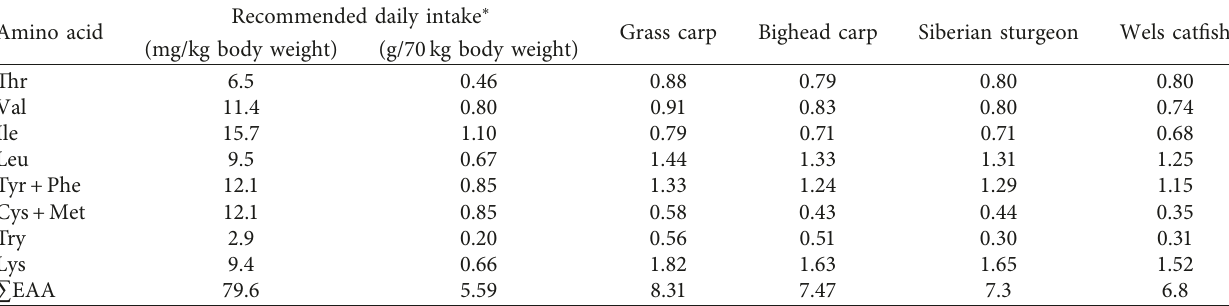
Table 6: Essential amino acid content in muscle (g/100g muscle) of grass carp, bighead carp, Siberian sturgeon, and wels catfish and the recommended daily intake for an adult man weighing